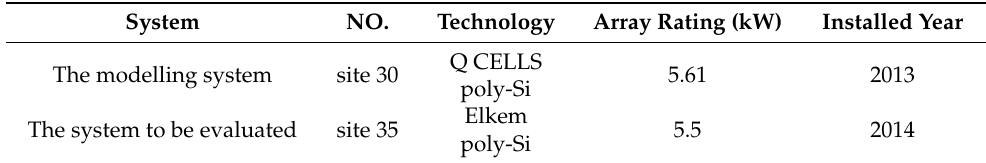
Table 1. System Parameters.